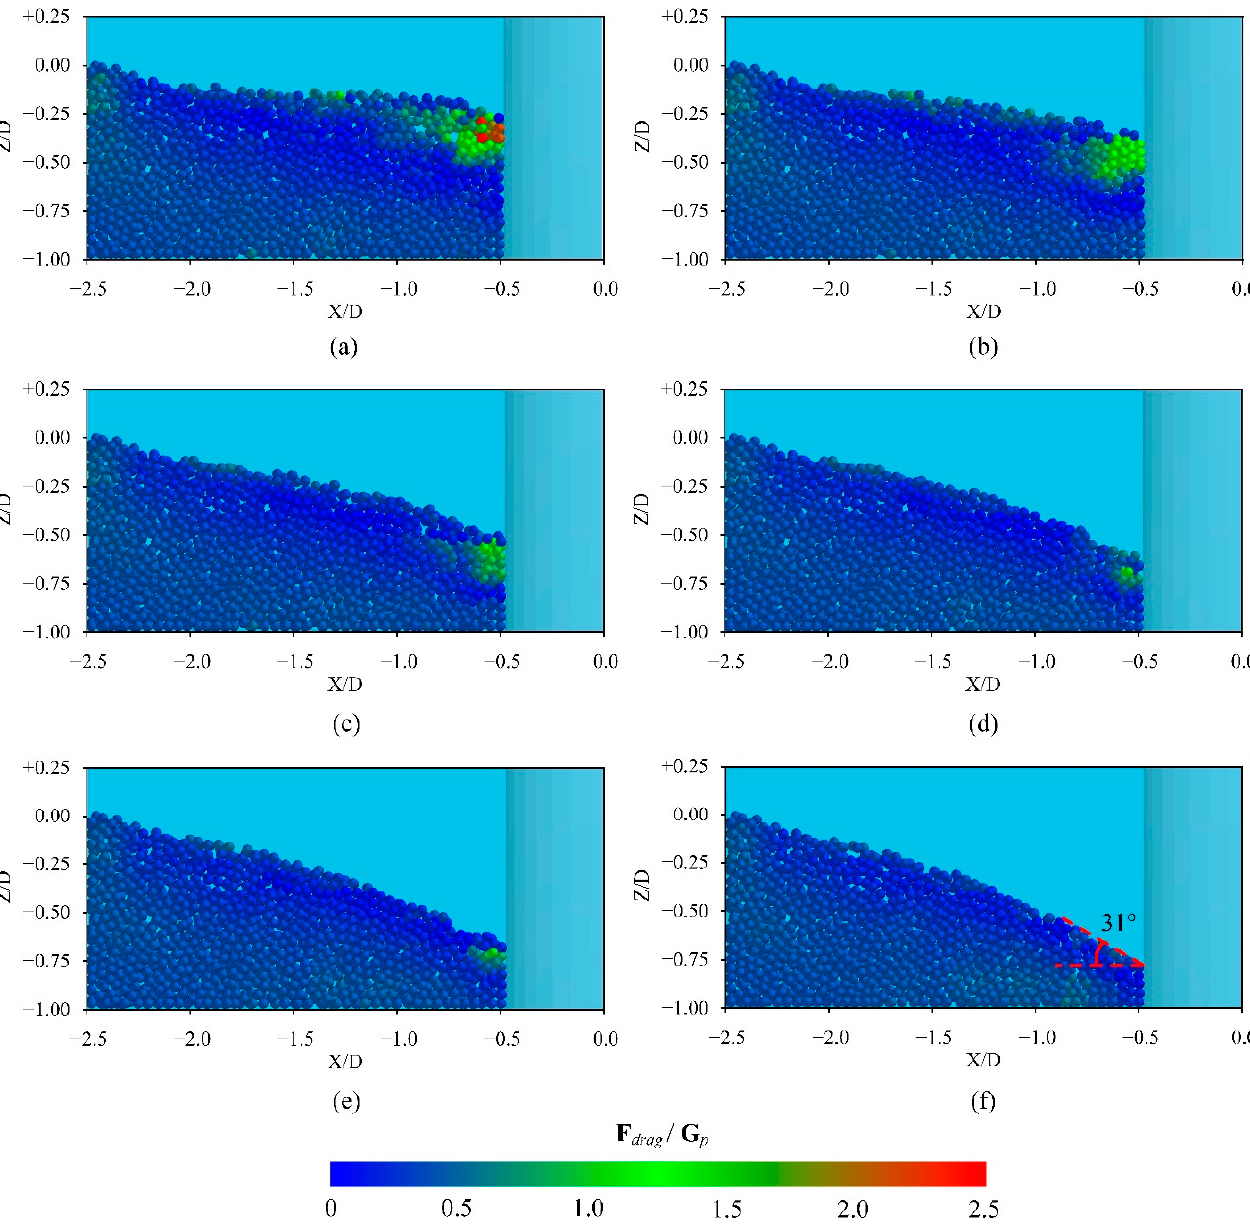
Figure 9. Morphological evolution of scour pits in front of piles: ( a ) t/t e = 0.025; ( b ) t/t e = 0.05; ( c ) t/t e = 0.1; ( d ) t/t e = 0.25; ( e ) t/t e = 0.5; and ( f ) t/t e = 1. F drag and G p is the drag force and weight of the sediment particles.